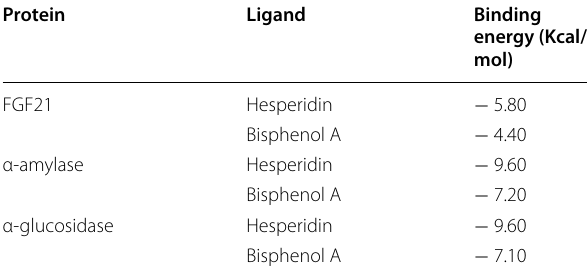
Table 1 Molecular docking scores for the best pose of the ligands